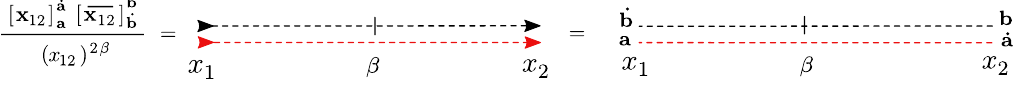
Figure 4 . Graphic representation of the propagator G dimension β = − u and generic spins ‘, ˙ ‘ . The two dashed lines stand for the spinorial structures in (2.16), the one with the bar denoting the matrix x . The arrows denote the flow of spinor indices, as made explicit by the r.h.s.